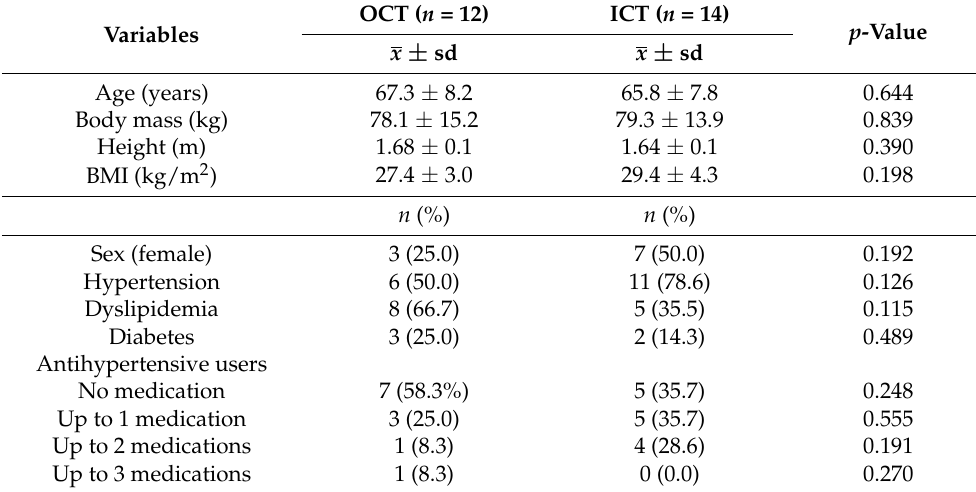
Table 1. General characteristics of the sample ( n = 26).